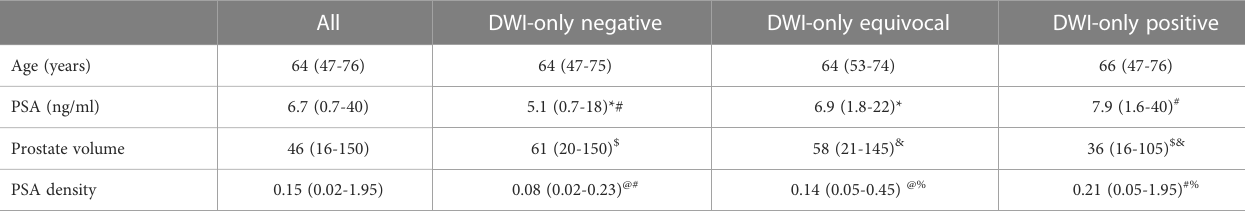
TABLE 1 Patient demographic and clinical data. Data are given as median and